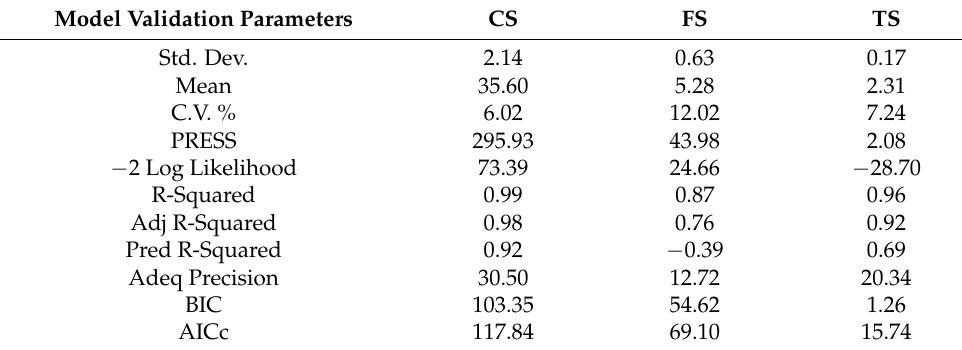
To further assess the quality and adequacy of the developed response models, two of the powerful model diagnostic tools employed are the “Normal versus Residual” plot and the “Actual versus Predicted plot” as presented in Figures 12–14, respectively for the three models (CS, FS, and TS). The linearity of the data points along the fit line illustrates the developed models’ quality in all graphs. The pattern of the data points on the normal plots of residuals indicates that the error terms are normally distributed, which is desirable. The residuals are normally distributed if 95% of the points lie between − 2 and +2, as is the case for all the developed models [66].